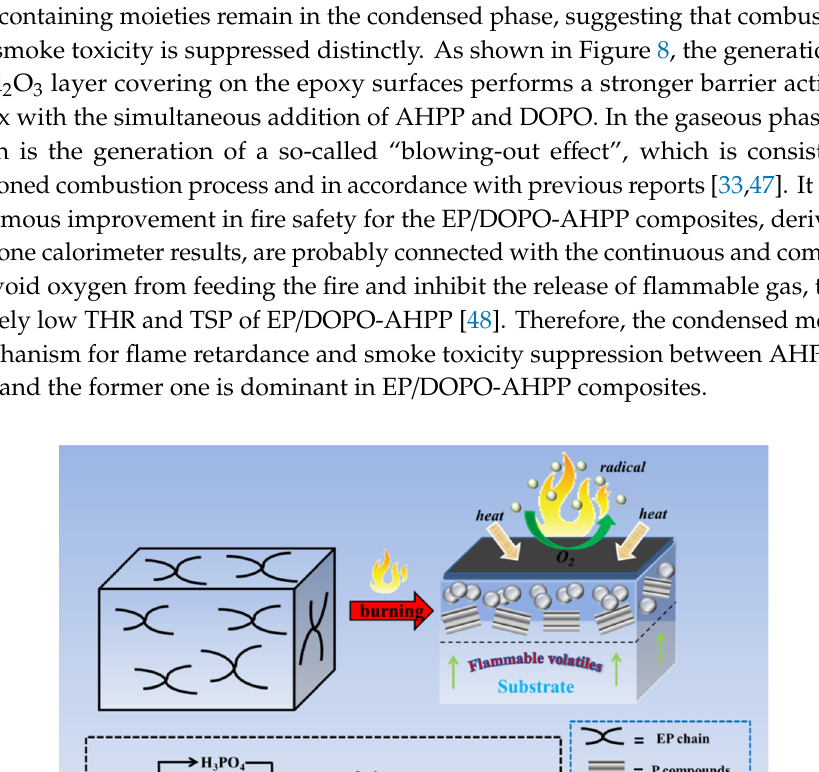
Figure 7. XRD patterns and FTIR spectra of the char residue of pristine EP and its composites from cone test.